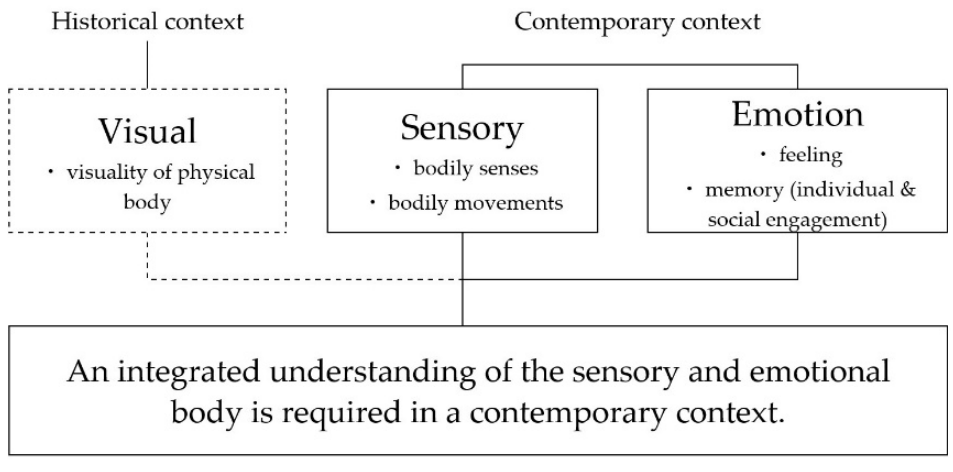
Figure 1. Phenomenological understanding of the body. Source: author’s drawing.